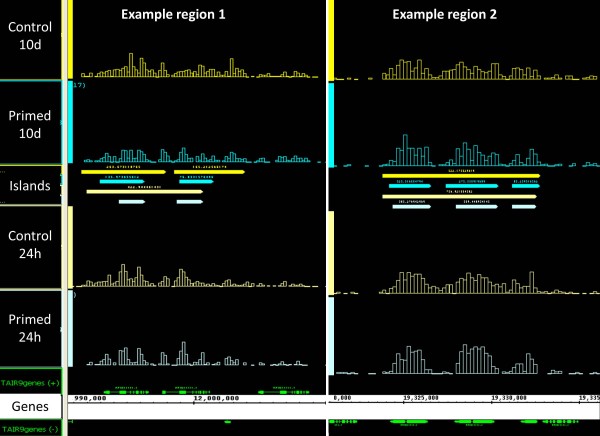
Examples of H3K27me3 islands etching 24 h and 10 days after priming. H3K27me3 profiles of primed and non-primed (control) root samples 24 h and 10 days after priming (screenshots of IGB display). Positions and lengths of islands identified by SICER are indicated with bars in the middle section. Note that in both example regions a long H3K27me3 island in the control samples is fractionated into a shorter island in the primed samples. This effect is still apparent after a 10-day growth period in control conditions.